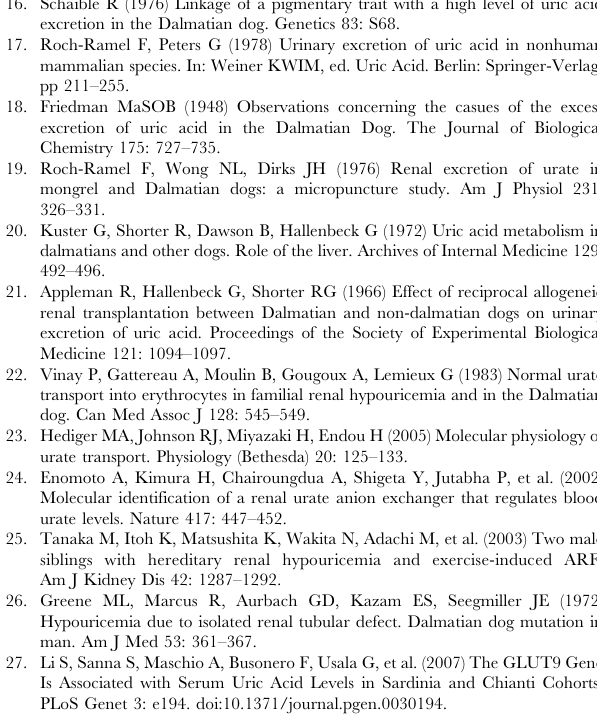
Table S2 Primers for SNPs used to define the Huu region.